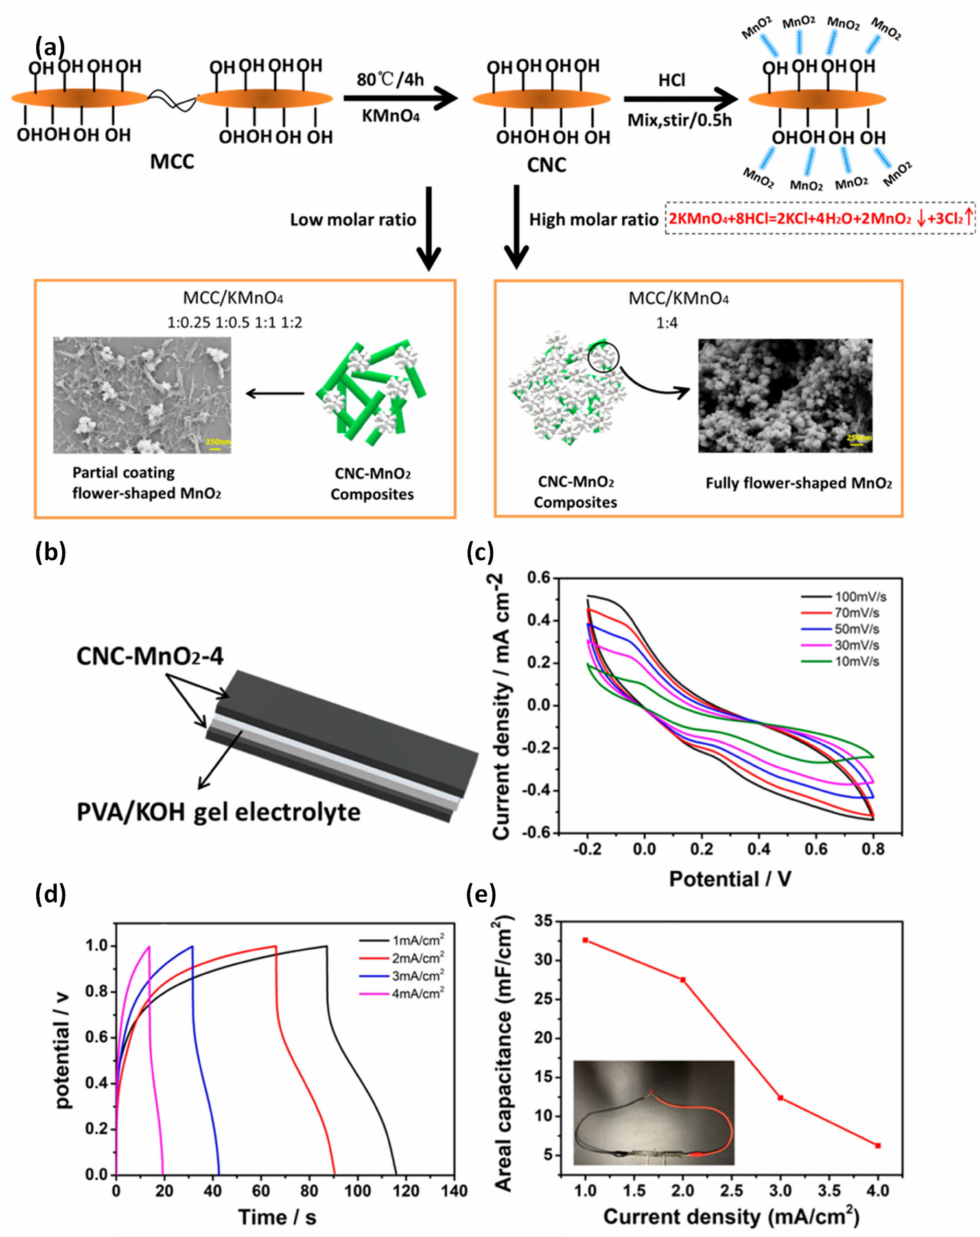
Figure 10. ( a , b ) Schematic synthetic route of the solid-state supercapacitor using the CNC − MnO 2 electrode. ( c – e ) CV curves, GCD curves and the areal capacitance of CNC − MnO 2 . Adapted with permission from [112]. Copyright American Chemical Society